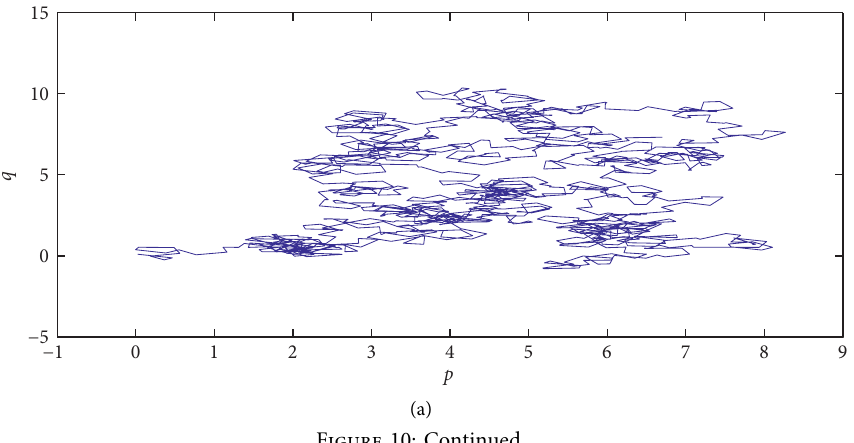
� − 0 . 1, green attractor for x 0